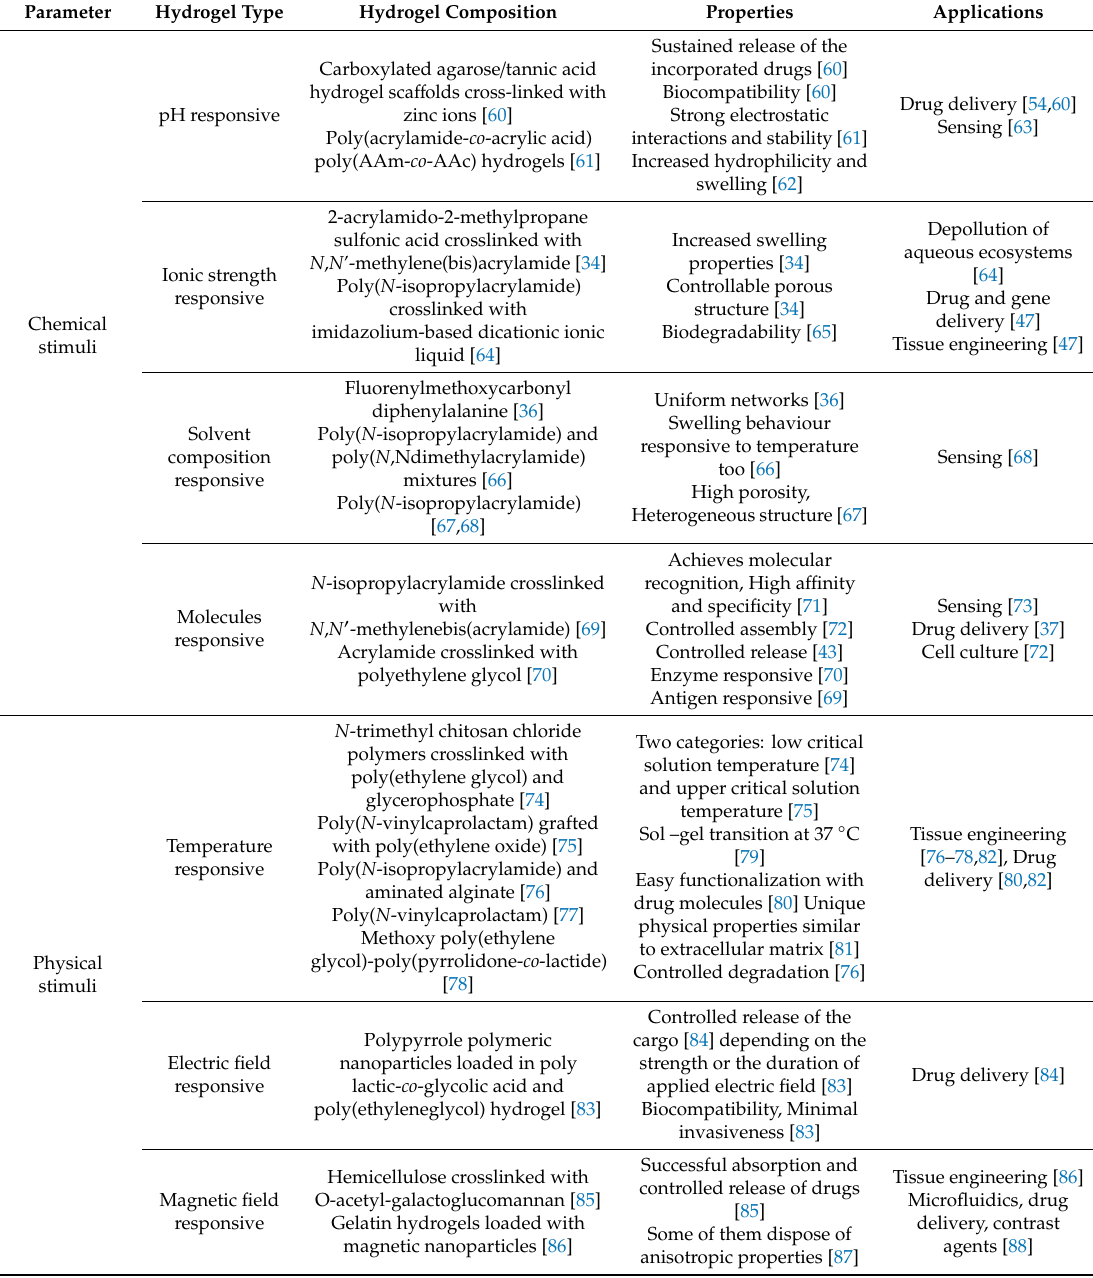
Table 1. Hydrogel classification according various parameters, their properties and corresponding